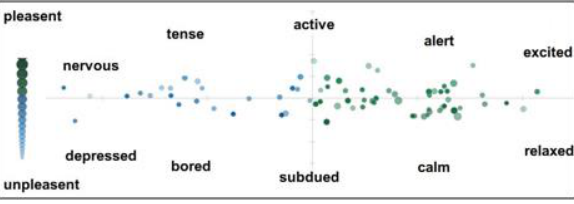
Figure 3. Sentiment analysis related to the hashtag #nuevoaeropuerto, September 2,